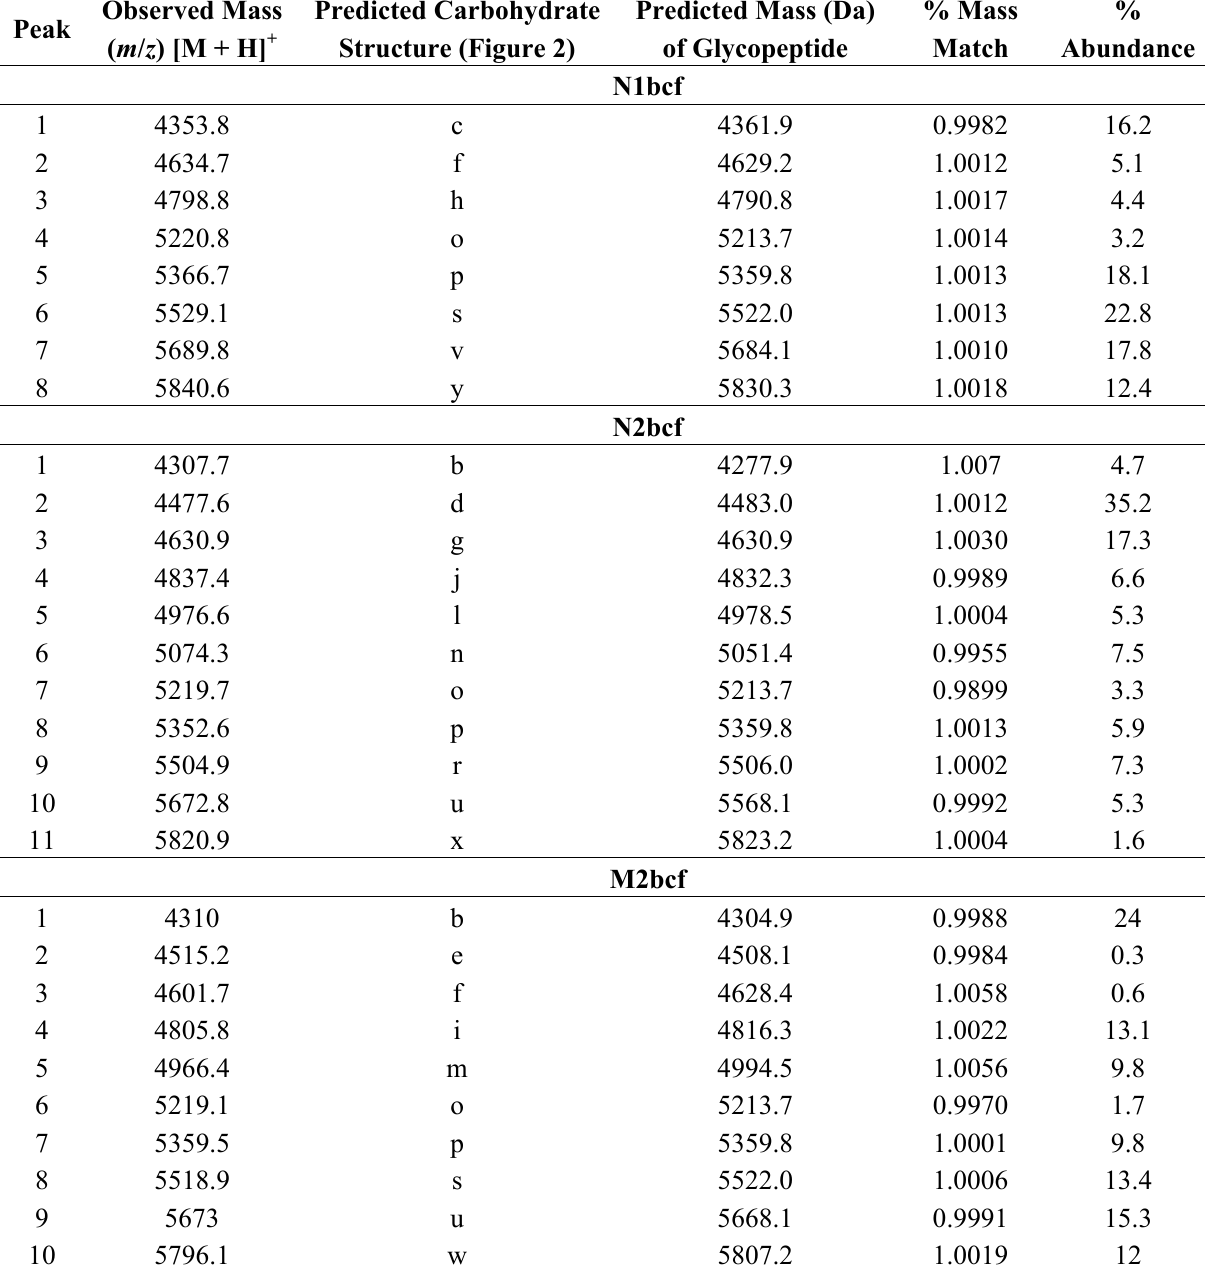
Table 1. Identifying MALDI TOF MS peaks. For each peak in each sample; an inferred oligosaccharide (CHO) mass was calculated and best fit structure assigned (Figure 2). The theoretical mass of the glycopeptides ( β 6–40 plus CHO moiety) was then calculated as percentage fit (mass match) to the observed peak mass. The calculated relative abundance of each observed peak represents the proportion of area under the curve for the mass spectral range ( m / z 4200–6000) for that peak/glycopeptides (%